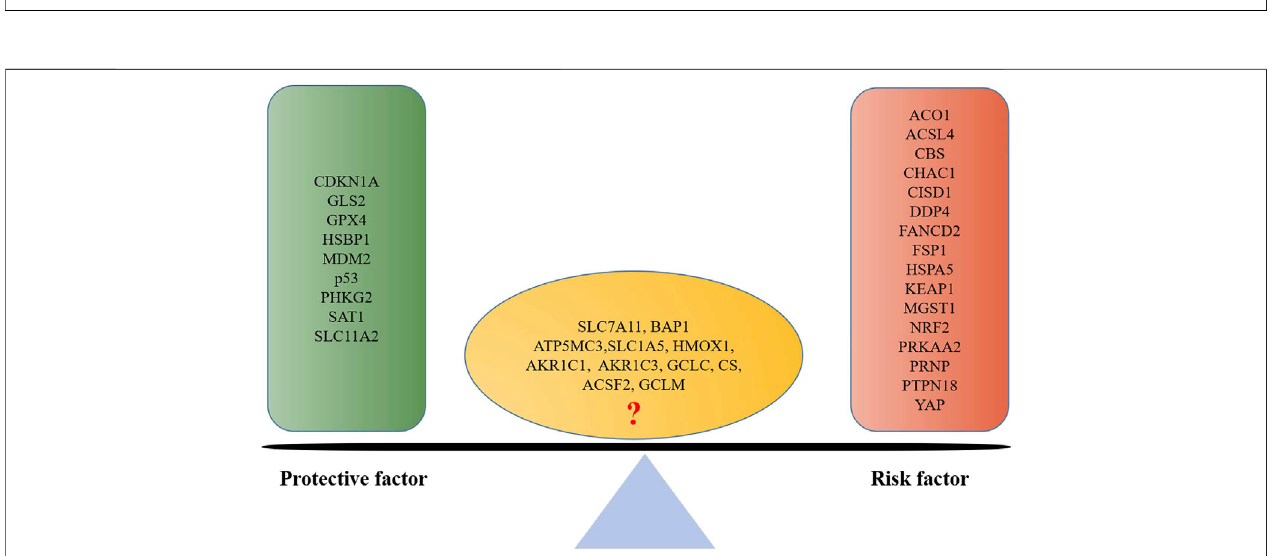
FIGURE 4 | Ferroptosis-associated gene-based protective factor and risk factor in endometrial cancer. A list is made of ferroptosis-associated genes involved in endometrial cancer prognosisbased on the previous literature;those which are positivelyassociated witha good prognosis arede fi ned asprotective factors, and those which are negatively associated are de fi ned as risk